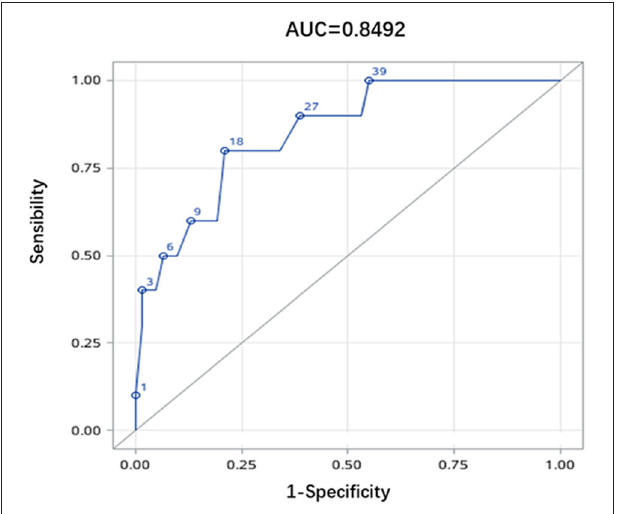
FIGURE 2 | Receiver operating characteristics curve. Receiver operating characteristics (ROC) curve analysis demonstrated an area under the curve of 0.8472 for the platelet count. An optimal cutoff value of platelet count was 18 × 10 9 /L, giving the sensitivity of 80.0% and the specificity of 79.0%. The Youden Index was